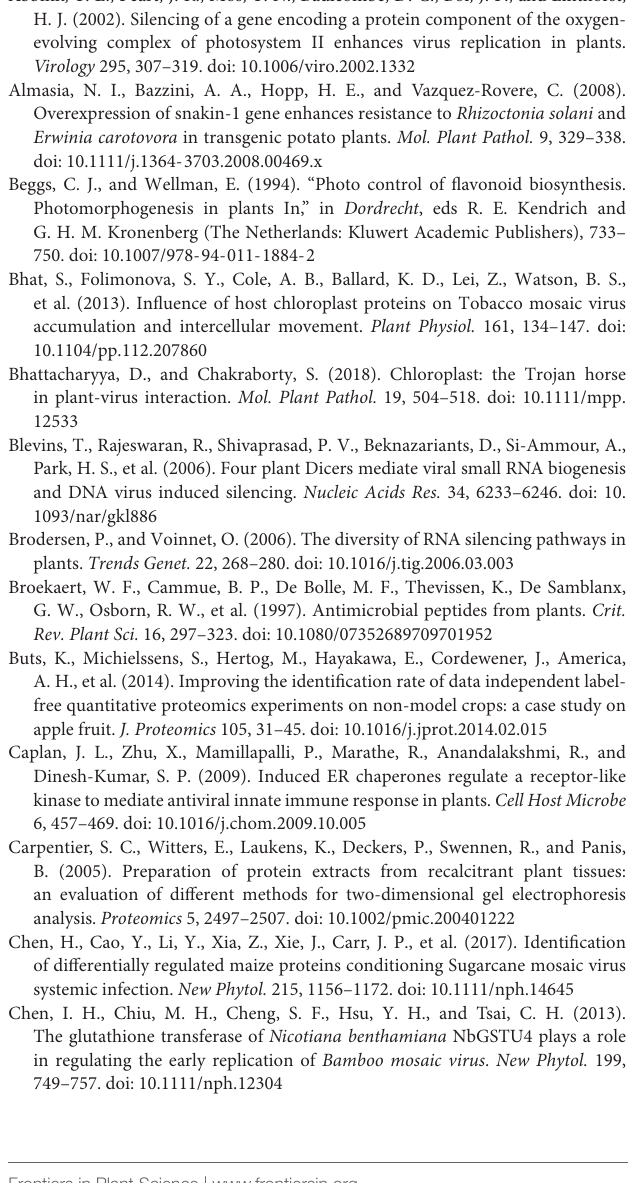
Supplementary Table 1 | Primers for the amplification of TMV p126 and Nt-ACT9 in RT-qPCR. Supplementary Table 2 | An overview of all significantly enriched GOs. Supplementary Table 3 | An overview of all the annotated GOs for the differentially accumulated proteins (DAPs). Supplementary Table 4 | Next generation sequencing (NGS) data showing the production of siRNAs in the dsRNAp126 treatment at 15 min post application (mpa).